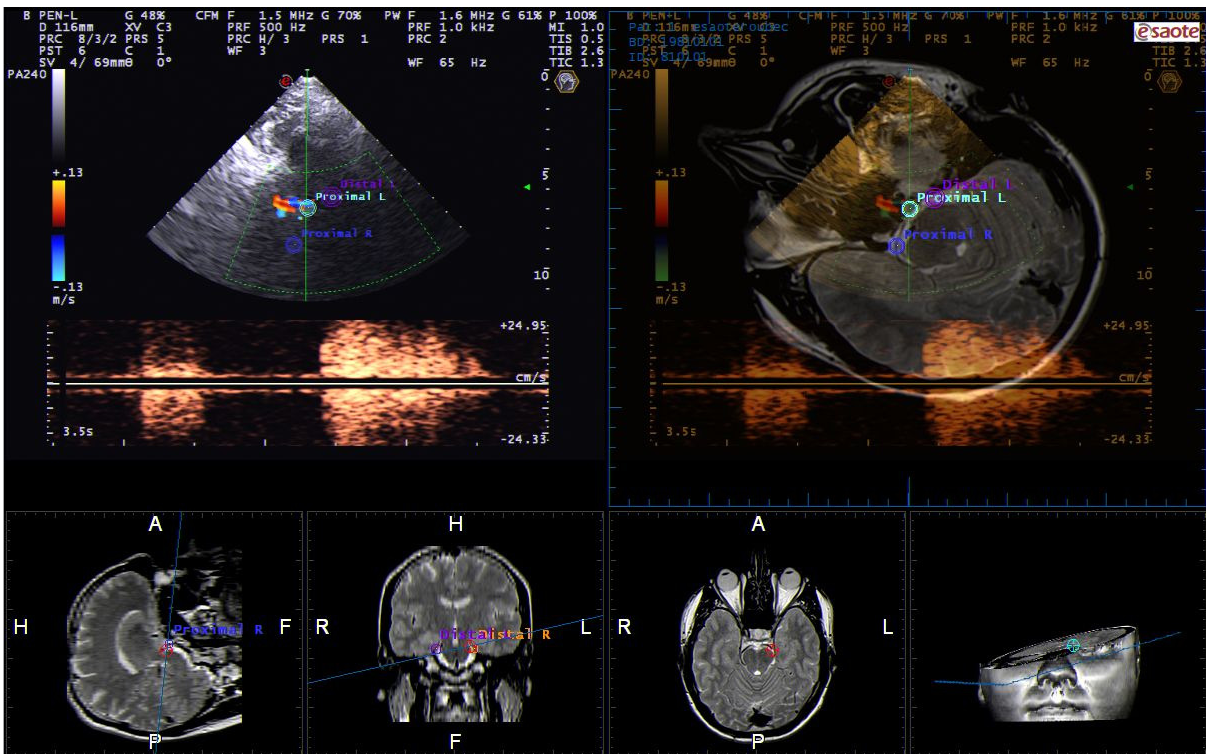
Fig. 2. Fusion Imaging technique: Breathing artifact in the region of cavernous sinus detected by transcranial color-coded duplex sonography from transcondylar approach using Doppler